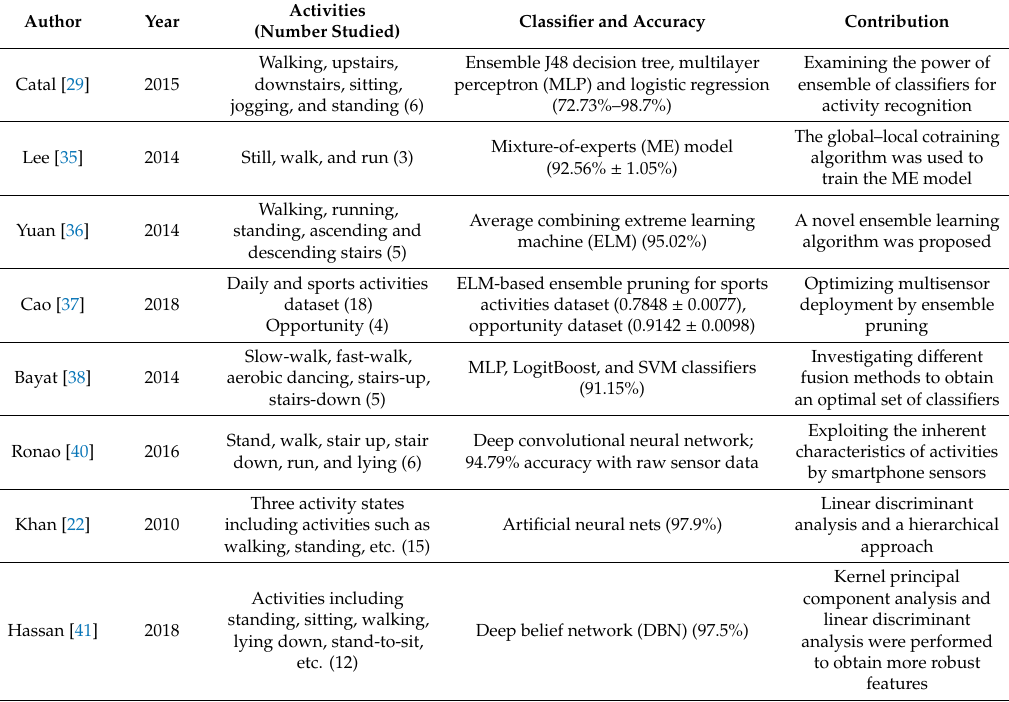
Table 1. Summary of notable activity recognition studies using wearable sensors on multiclassifier schemes and